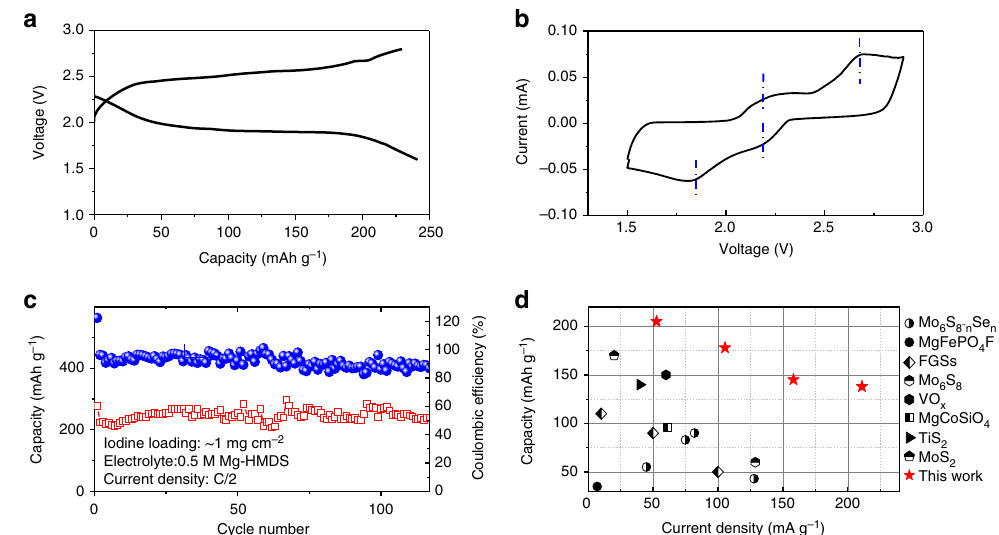
Figure 3 | Electrochemical performance of the rechargeable Mg/I 2 battery. ( a ) A typical discharge/charge curve of the Mg/I 2 battery with ACC/I 2 cathode. ( b ) Cyclic voltammogram of the Mg/I 2 battery with ACC/I 2 cathode. Scan rate: 0.1mVs (cid:2) 1 . ( c ) Cycling stability of the Mg/I 2 battery at 0.5C (105.5mAg (cid:2) 1 ) with ACC/I 2 cathode. ( d ) Rate capability of Mg/I 2 battery with ACC/I 2 cathode. The rate capabilities of other cathode materials are also plotted for